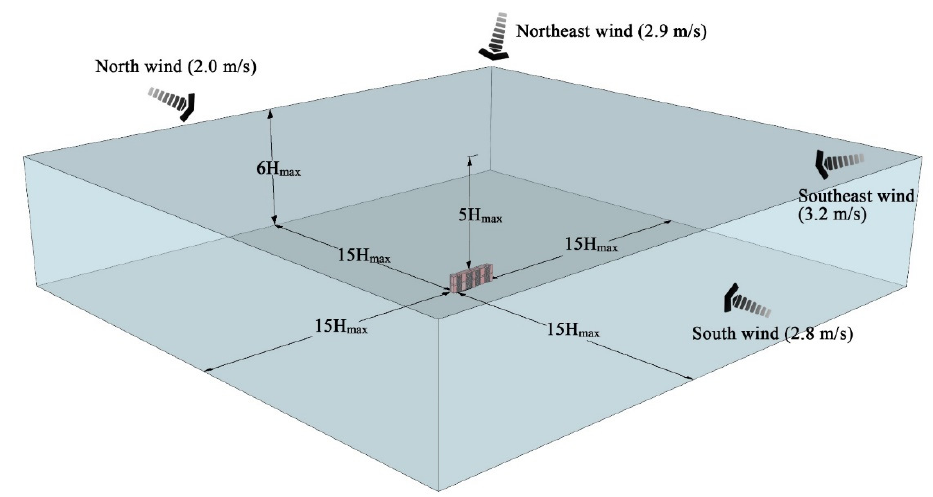
Figure 5. Size of the computational domain and its relation to the buildings.